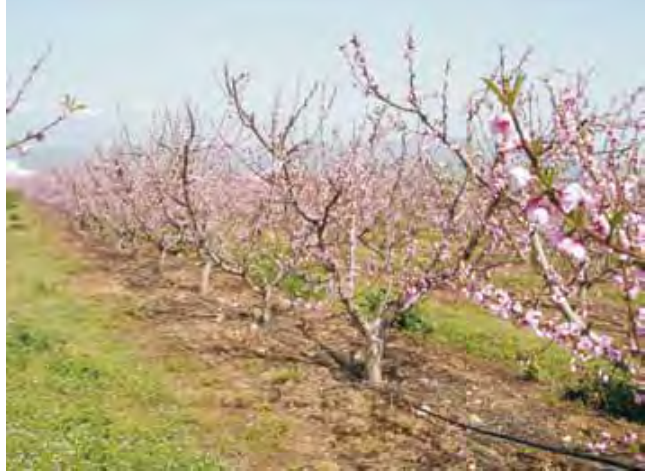
Fig. 8 - Catalonian vase during the fourth growing season at blooming in the Sibari area. The skeleton is completed and the plant is dwarf and